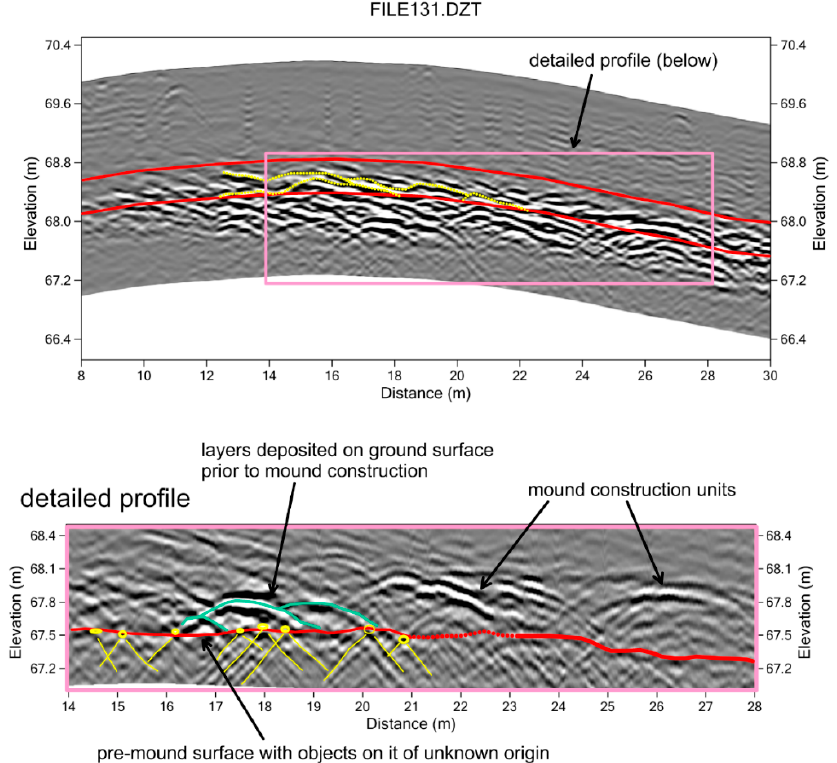
Figure 8. Reflection profile that images the materials placed on the pre-mound surface, with a detailed profile of one part of the surface, after the reflections were frequency filtered to include only those between 400 and 600 MHz, which removed some of the broader planar reflections and enhanced the point-source reflection hyperbolas (axes of which are shown in yellow).